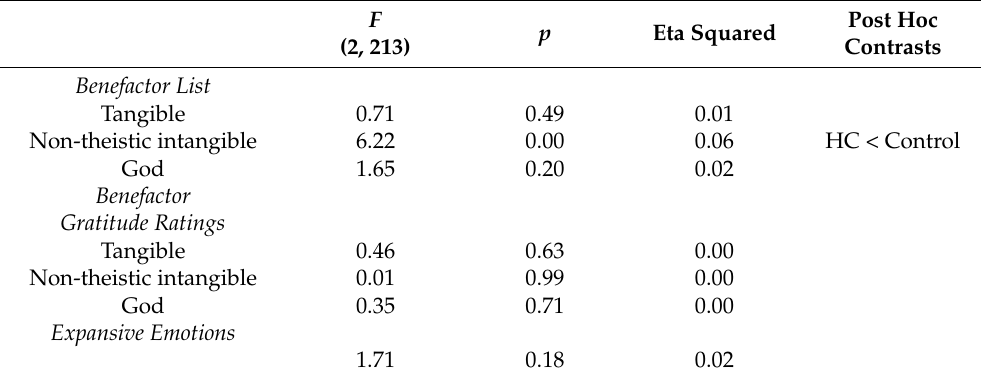
Table 1. Hypothesis 1: Conditional differences across the proportion of types of benefactors in benefactor lists, gratitude ratings, and expansive emotions.